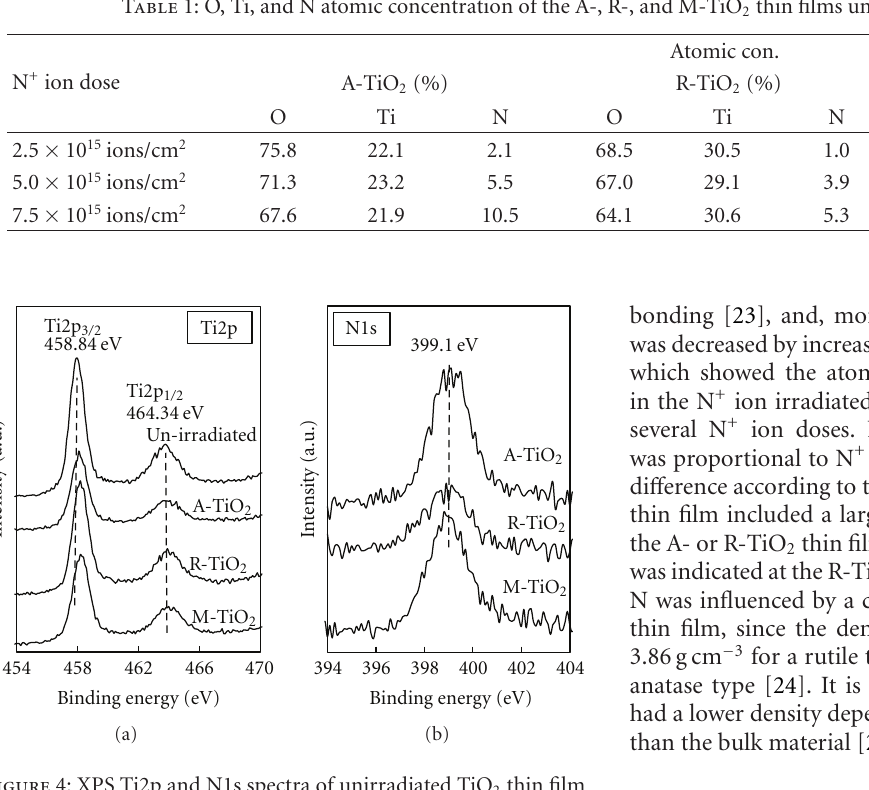
Figure 4: XPS Ti2p and N1s spectra of unirradiated TiO 2 thin film and the irradiated A-, R-, and M-TiO 2 thin film with an N + ion dose of 5.0 × 10 15 ions/cm 2